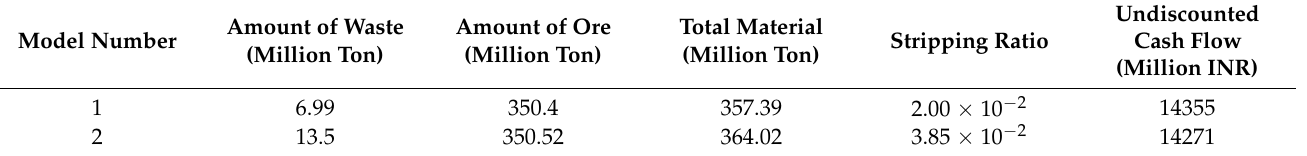
Table 4. Amount of waste, ore, total materials, and stripping ratio of an ultimate pit of the deposit for Model 1 and Model 2.